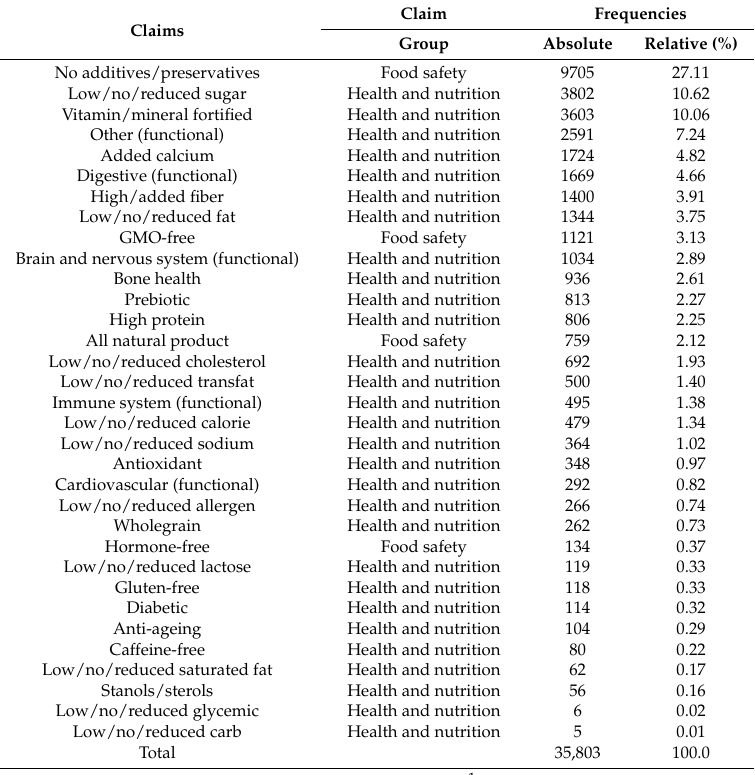
Table 2. Frequency distribution of products with health, nutrition, and food safety claims 1 .